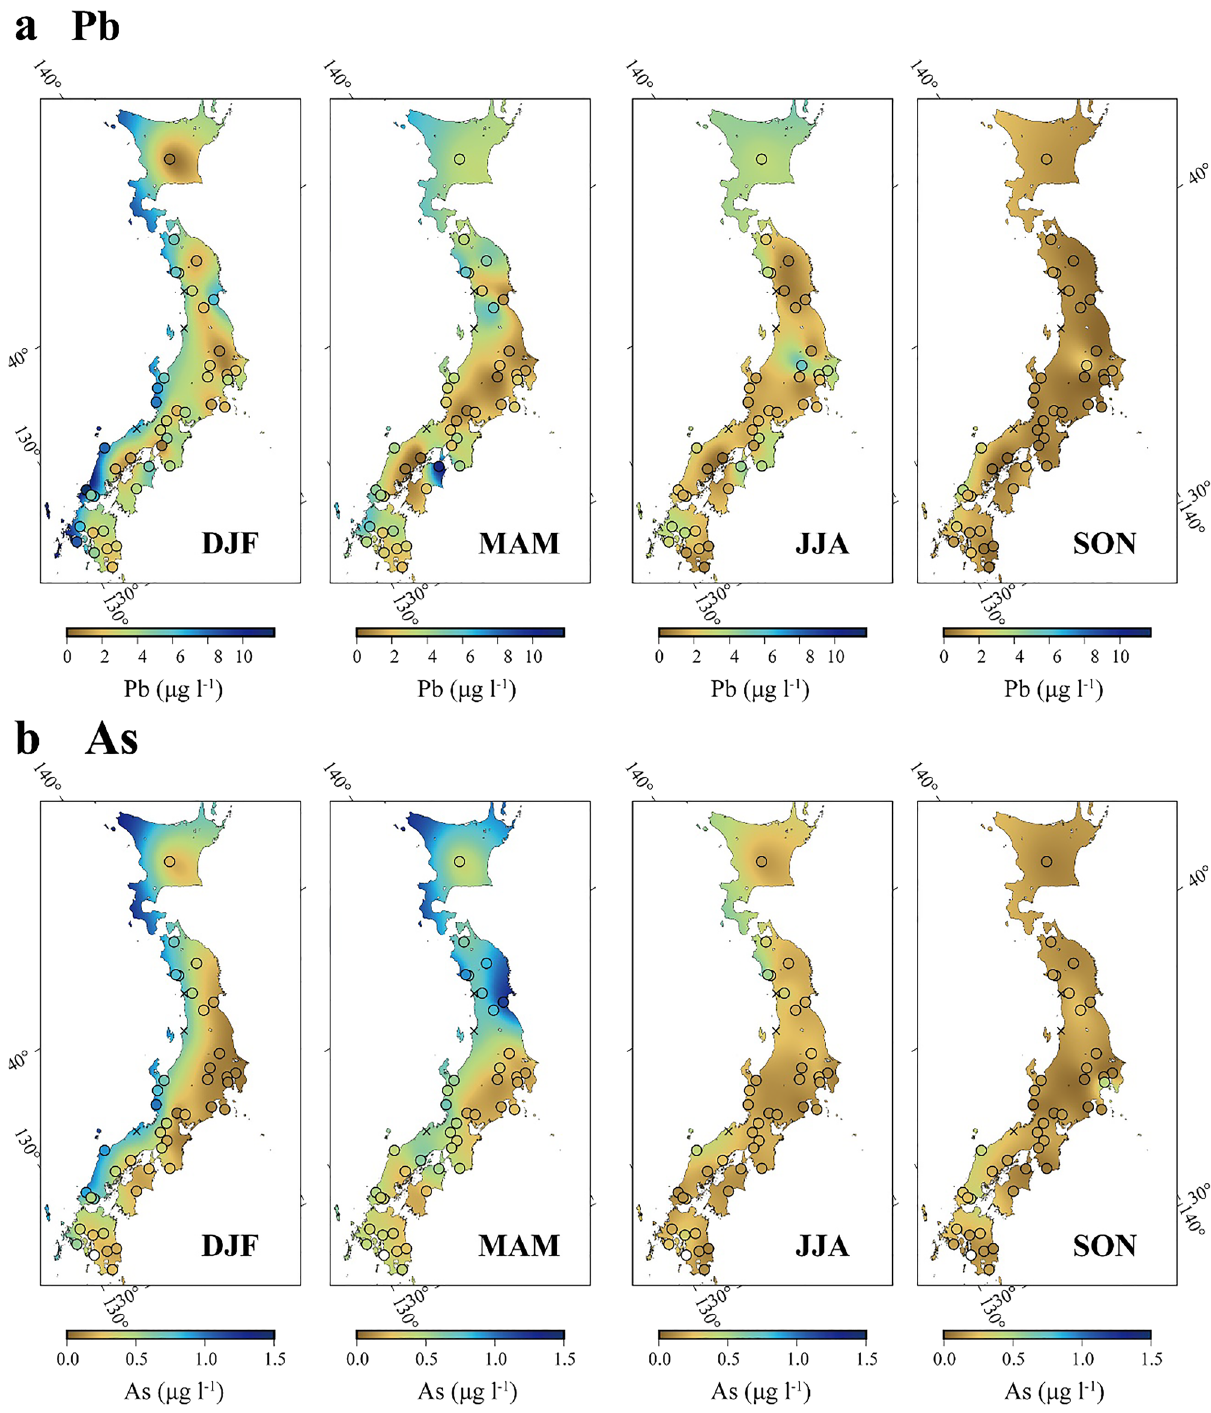
Figure 2. Spatiotemporal variation of Pb and As. ( a,b ) Maps showing distributions of average Pb and As concentrations, respectively, in precipitation samples collected over Japanese archipelago for four different seasons. The circles indicate the sampling locations, and each cross indicates the location where the average concentration of two neighboring locations was assumed. All maps were drawn by using GMT (Version